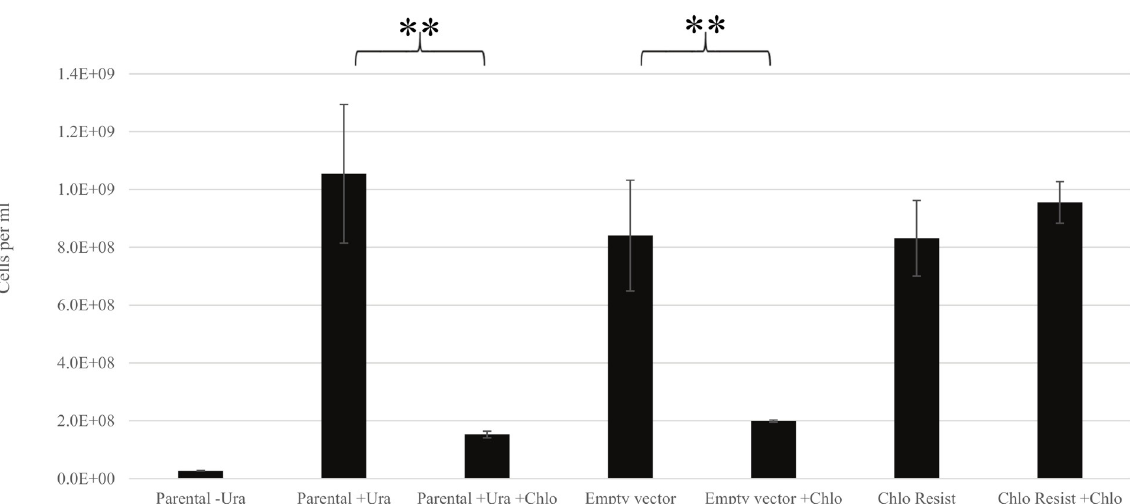
Fig 2. S . cerevisiae growth under chloramphenicol selection. “Parental” refers to the parental, untransformed S . cerevisiae yeast strain 31019b. “Empty vector” refers to the parental yeast strain transformed with a pYES2.1 vector carrying an eGFP coding region. “Chlo Resist” refers to the parental yeast strain transformed with a pYES2.1 vector carrying the chloramphenicol acyltransferase (CAT) resistance gene (ChloR). “+Chlo” indicates treatment of cultures with chloramphenicol. “+Ura” and “-URA” indicate the presence and absence of uracil supplement in the growth media respectively. Results are from five biological replicates. Asterisks indicate significantly different means with a p-value of < 0.01 using Student’s t-test with unequal variance. T-test was carried out with a significance value of 0.05. Error bars indicate standard error of the mean (S17 File).